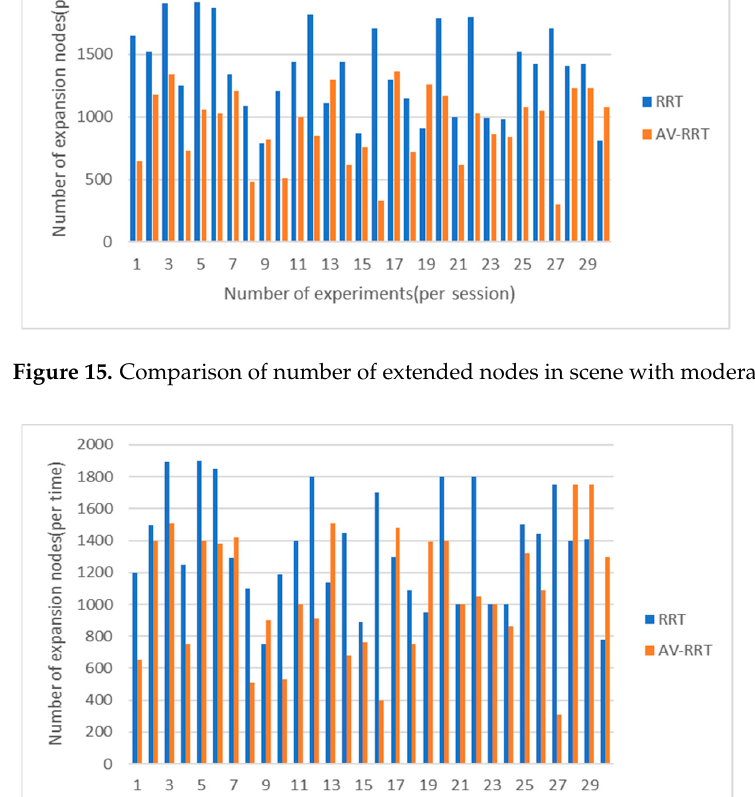
Figure 16. Comparison of number of extended nodes in scene with dense obstacles.